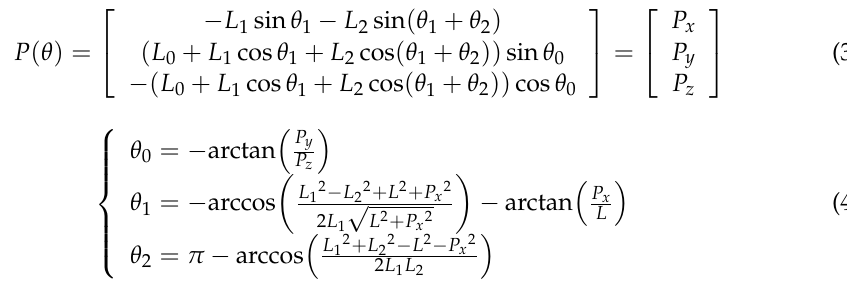
Figure 4. Leg stretch with the definition of the leg geometry ( L 0 , L 1 , L 2 ), the cylinder mounting position ( a 0 , b 0 , a 1 , b 1 , a 2 , b 2 , e 11 , e 12 , e 21 , e 22 , ϕ ), the cylinder length ( c 0 , c 1 , c 2 ), joint angles ( θ 0 , θ 1 , θ 2 ), and labels of three leg joints, RAA: root abduction/adduction, HFE: hip flexion/extension, KFE: knee flexion/extension: ( a ) KFE and HFE; ( b ) RAA.